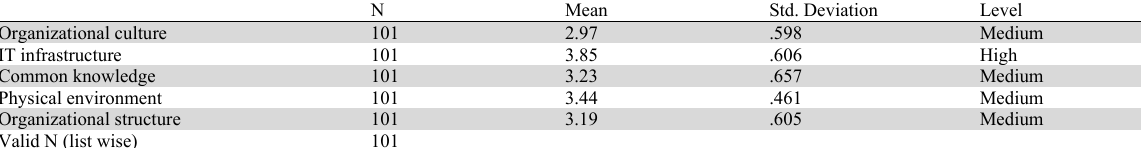
KM Infrastructure Arithmetic Means and Standard Deviations